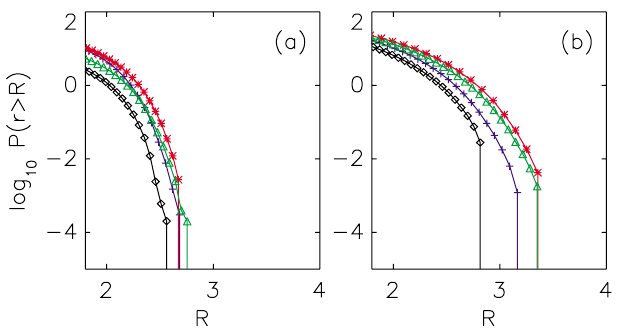
FIG. 6. (Color) Plots of P (cid:6) r > R (cid:7) vs R in the presence of both the n (cid:2) 1 and n (cid:2) 2 modes ( N (cid:2) 10 6 ) at the end of the (cid:2) 80 , various values of simulation ( t (cid:2) 512 ) for fixed t c , with noise strength (a) hj (cid:22)! ji (cid:2) 0 : 001 mode amplitudes (cid:13) 1 ; 2 (cid:2) 0 : 05 , and (b) hj (cid:22)! ji (cid:2) 0 : 01 . Blue curve with crosses: (cid:13) 1 (cid:2) 0 : 1 ; red curve with asterisks: (cid:13) (cid:2) 0 : 1 , (cid:13) (cid:2) 0 : 05 ; black (cid:13) 2 1 2 (cid:2) 0 : 05 , (cid:13) (cid:2) 0 ; green curve with curve with diamonds: (cid:13) 1 2 (cid:2) 0 : 1 , (cid:13) (cid:2) 0 triangles: (cid:13) 1 2